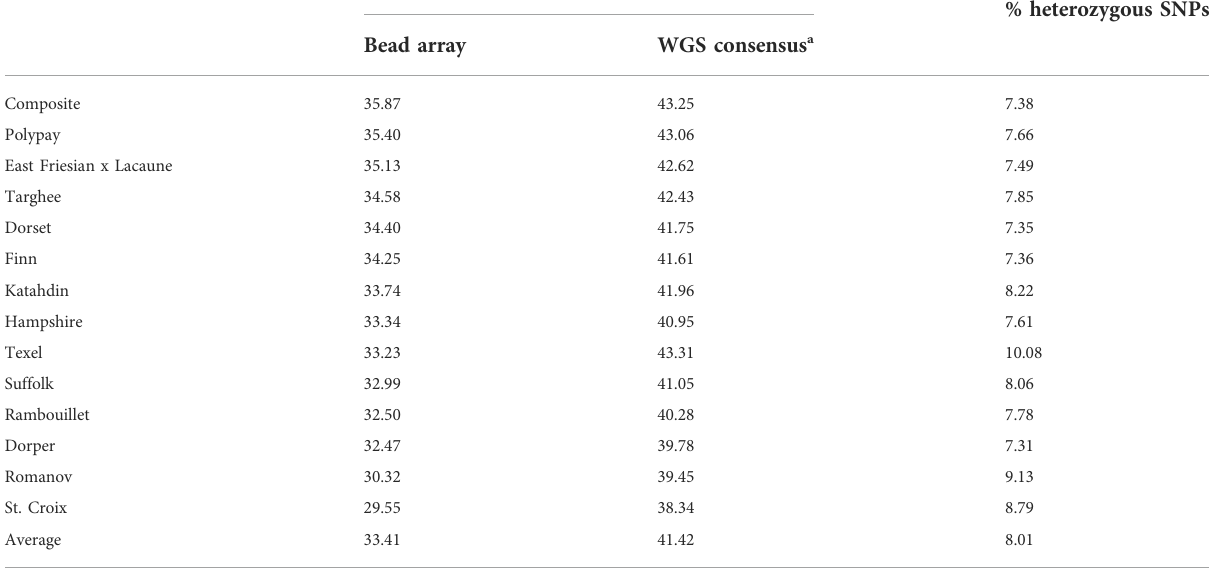
TABLE 4 Comparison of average percent heterozygous SNPs for bead array and consensus genotyping from WGS data.